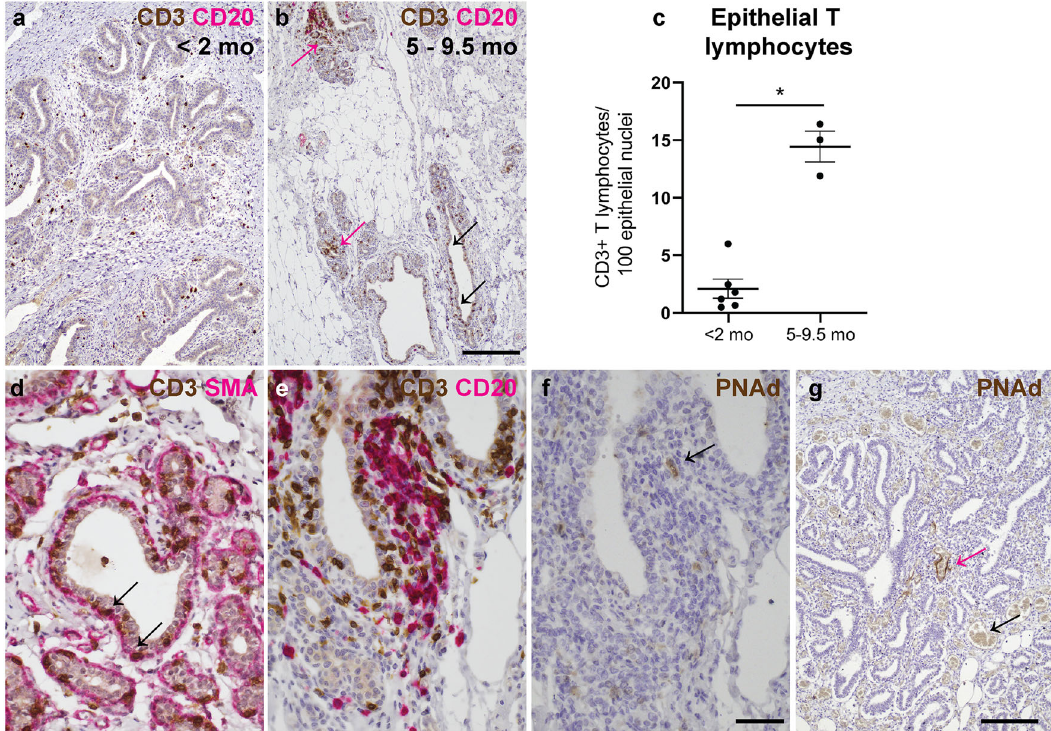
Fig. 5 Epithelial T lymphocytes are more abundant in older lambs, and tertiary lymphoid structures are multifocally present. a , b IHC for CD3 (brown) and CD20 (pink) reveals more abundant intraepithelial (black arrows) T lymphocytes in lambs aged 5 – 9.5 mo. Pink arrows indicate stromal T lymphocytes. c Scatter plot demonstrating that the distribution of epithelial T lymphocyte counts differs signi fi cantly between younger and older lambs. Dots represent CD3 + lymphocyte densities from individual lambs. Bars represent mean ± standard deviation. * p < 0.05. d IHC for CD3 (brown) and SMA (pink). Arrows indicate intraepithelial lymphocytes. e IHC for CD3 (brown) and CD20 (pink). An aggregate of lymphocytes in a subepithelial focus exhibits a central zone of B lymphocytes surrounded by T lymphocytes. f , g IHC for PNAd. f Serial section of ( e ). Arrow indicates high endothelial venule within the aggregate of lymphocytes depicted in ( e ). g Pink arrow indicates PNAd-positive blood vessel amidst lymphocytic in fi ltrate. Black arrow indicates adjacent negative internal control blood vessel, demonstrating speci fi city of staining. Images are representative of six ( a ) and three ( b , d – g ) biological repeats; mo, months old. All IHC images have haematoxylin counterstain. Scale bar = 200 μ m ( a , b ); 40 μ m ( d – f ); 200 μ m ( g